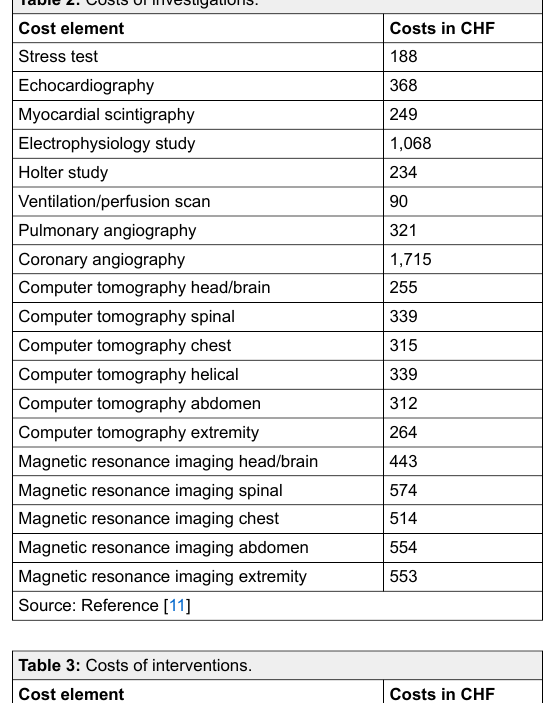
Table 3: Costs of